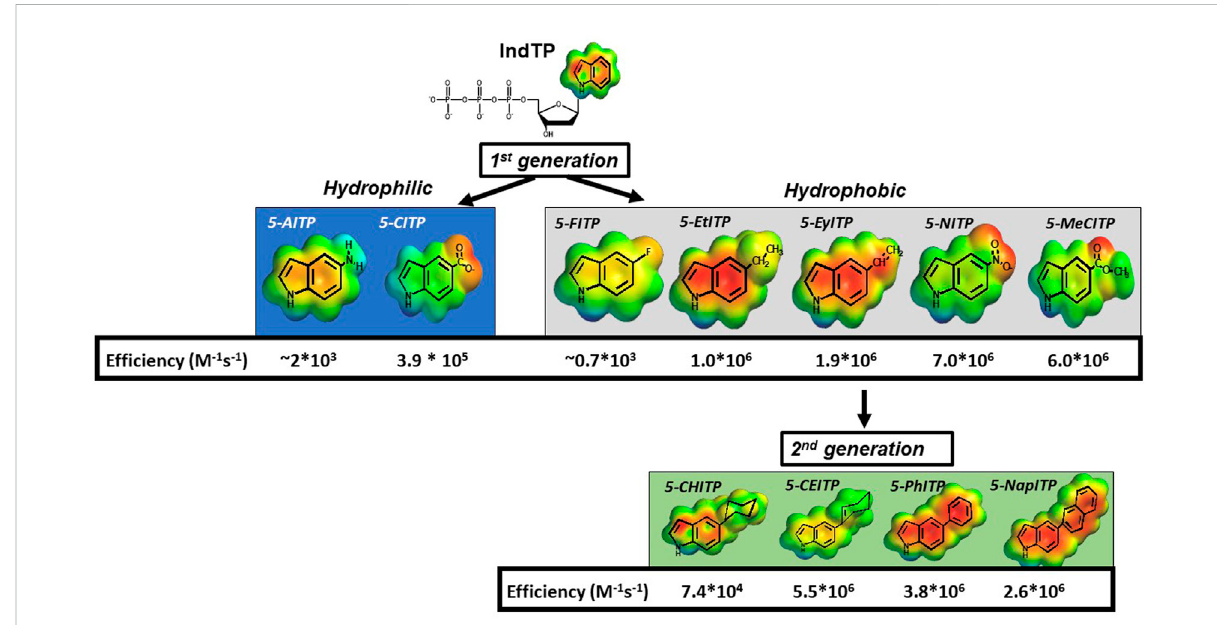
FIGURE 7 Structures of various 5-substituted indolyl deoxynucleotides tested as nucleotide substrates for DNA polymerase during the replication of an abasic